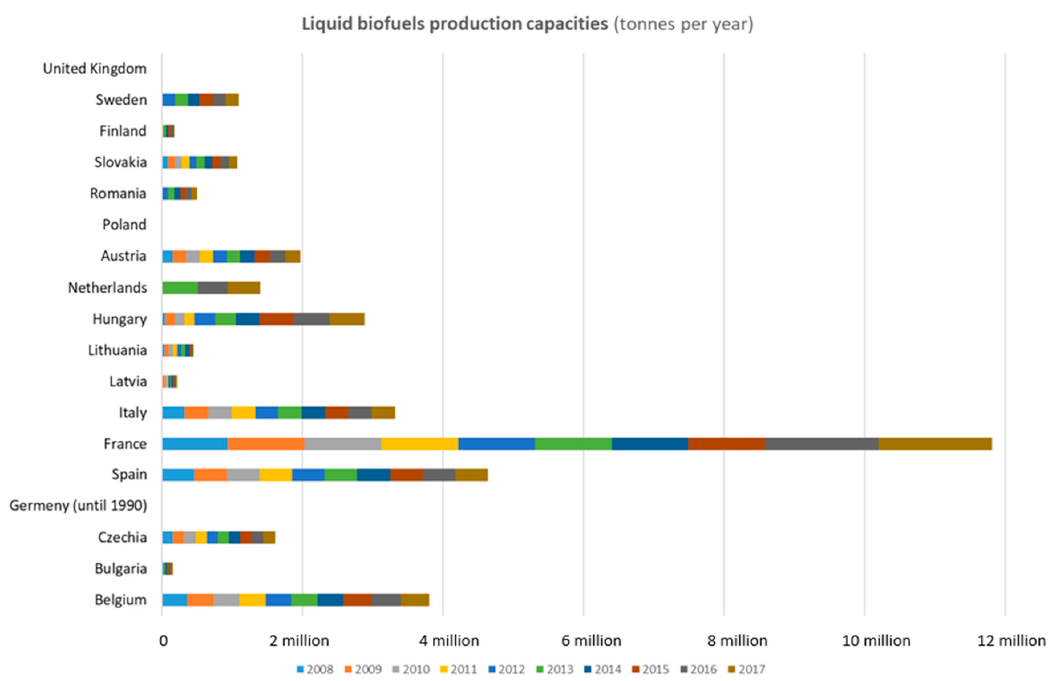
Figure 1. Liquid biofuels production capacities (Source: Eurostat. Last update: 25 February 2019). Pool fires are defined as flames established over horizontal fuel surfaces (as opposed to wall fires, which involve vertical fuel surfaces) [11]. Generally, pool fire’s surfaces have defined boundaries, and the depth of the liquid fuel pool is driven by the accumulation of fuel in the prescribed area. Gottuk and While [6] added one more minimum parameter—the depth of the liquid pool greater than 1 cm.